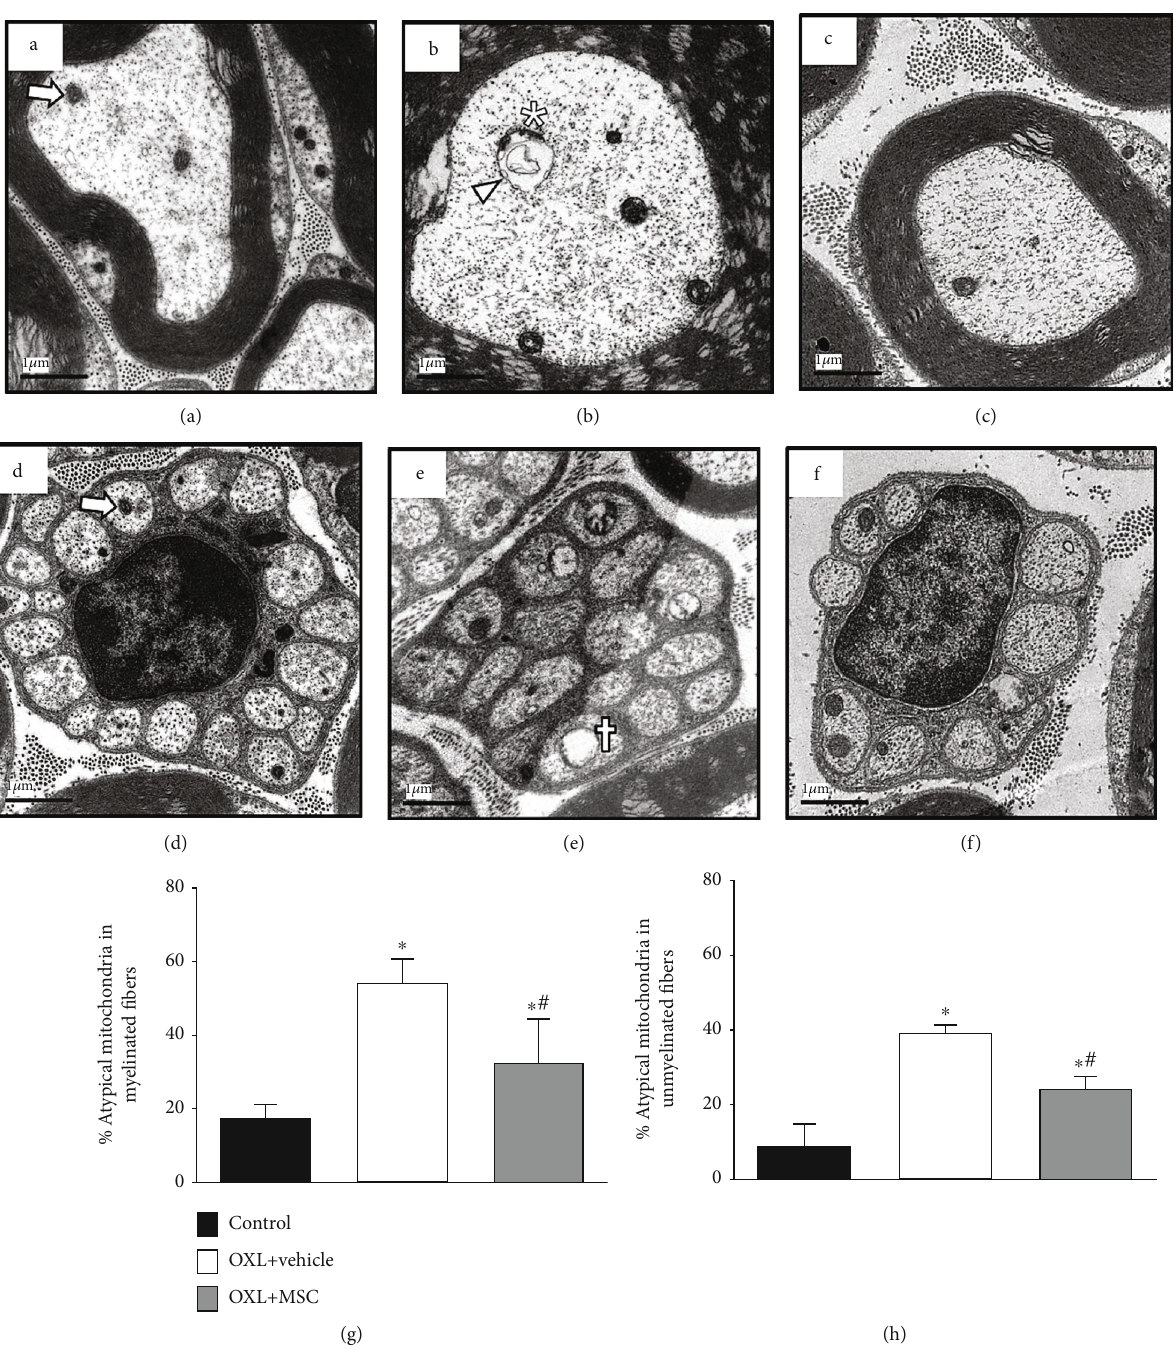
Figure 2: E ff ect of MSC on mitochondrial morphology and morphometry on sciatic nerve sensory fi bers of mice with OXL-induced chronic neuropathy. Transmission electron micrographs of sciatic nerve cross-sections from nonneuropathic mice (control group) and neuropathic mice treated with vehicle (OXL+vehicle) or with 1 × 10 6 MSC (OXL+MSC). Panels show myelinated (a – c) and unmyelinated (d – f) fi bers of the sciatic nerve. Analyses were performed 4 weeks after treatments. Electron micrograph of the control group reveals mitochondria with double intact membrane and absence of vacuolated intramitochondrial spaces and organelles with normal proportion area (arrow) in both myelinated (a) and unmyelinated fi bers (d). Vehicle-treated neuropathic mice presented atypical mitochondria, characterized by increased organelle size (arrowhead), presence of vacuole greater than 50% of the mitochondrial area (asterisk), and accumulation of electron-dense amorphous material at the mitochondrial pole (cross), in both myelinated (b) and unmyelinated (e) fi bers. MSC-treated neuropathic mice presented fewer mitochondrial morphological alterations in sensory fi bers relative to vehicle-treated neuropathic mice (c, f). (g, h) show the percentage of atypical mitochondria found in myelinated and unmyelinated fi bers, respectively. Scale bar = 1 μ m . Data are expressed as means ± standard deviation ; n = 6 mice per group. ∗ Statistical signi fi cance relative to the control group ( p < 0 : 001 ); # statistical signi fi cance relative to the OXL+vehicle group ( p < 0 : 05 ), as determined by one-way ANOVA followed by Tukey ’ s multiple comparison